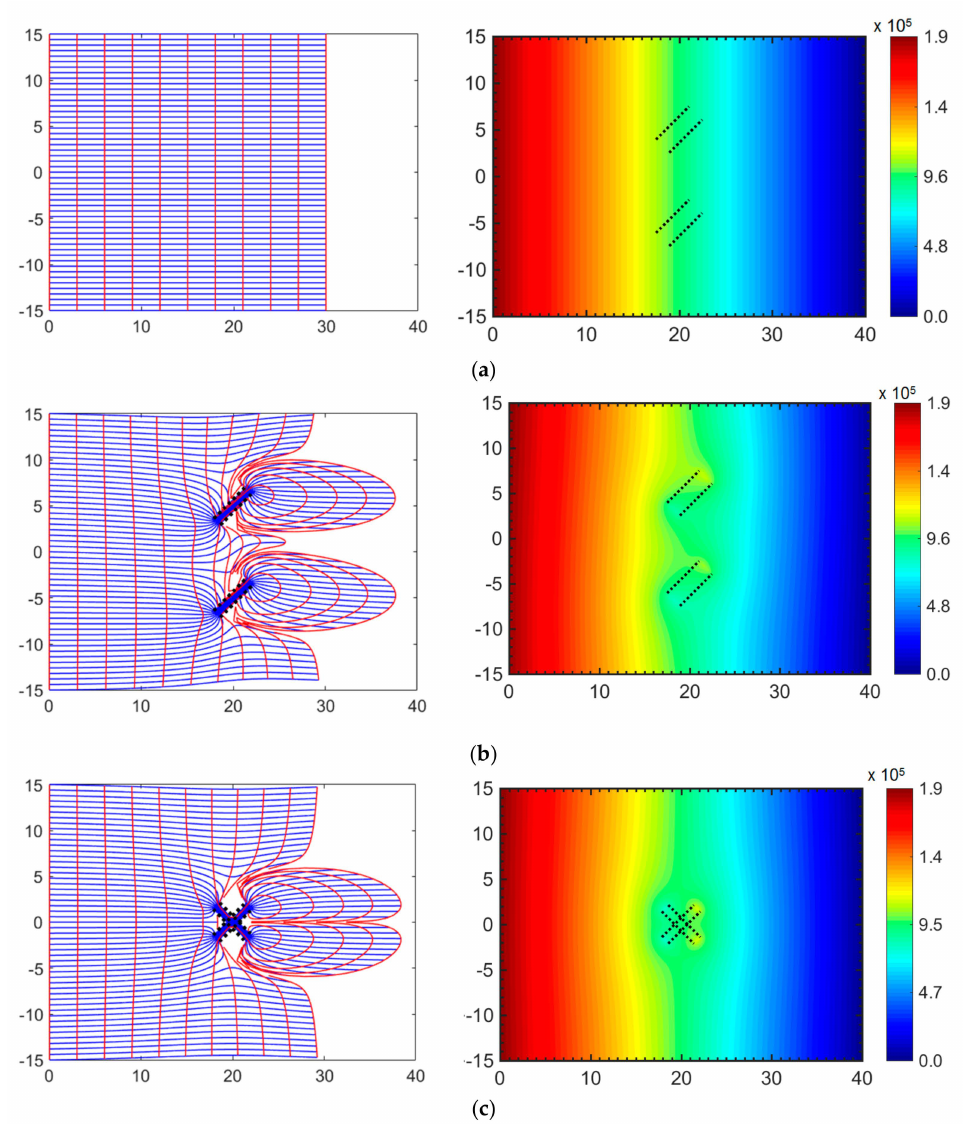
Figure 17. Left column: Streamlines (blue) and TOFC (red) due to a far-field flow with a uniform velocity of 0.15 m · year − 1 . Three cases are shown: ( a ) Base Case: Homogeneous reservoir with no enhanced permeability flow channels. ( b ) Case A: Two parallel enhanced permeability flow